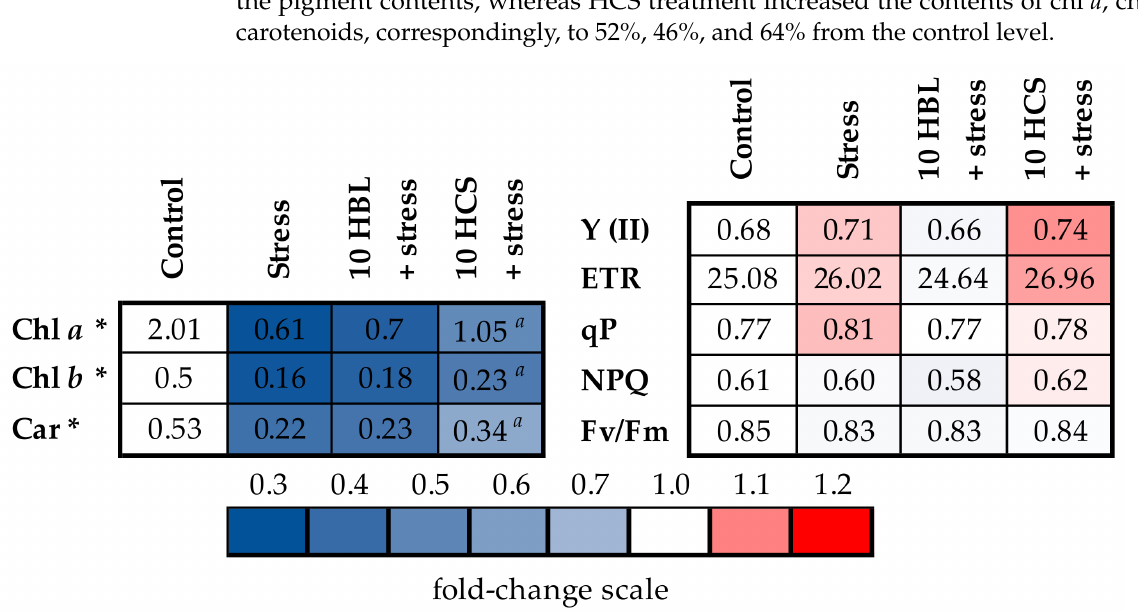
Figure 3. The effects of heavy metal stress and treatment with brassinosteroids on the primary photosynthetic processes and concentrations of photosynthetic pigments (mg/g fresh weight) in barley plants. The value in the control plants was taken as 1.0, the relative decrease is indicated in blue, and the relative increase is indicated in red. Asterisks (*) indicate significant differences from the control variant, and the a letter indicates significant differences from the polymetallic stress-treated variant ( p <